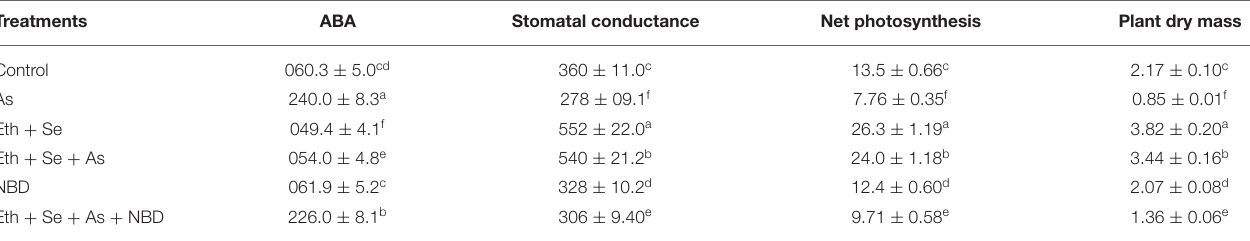
TABLE 4 | The ABA content (pmol g − 1 FW), stomatal conductance (mmol CO 2 m − 2 s − 1 ), net photosynthesis ( µ mol CO 2 m − 2 s − 1 ), and plant dry mass (g plant − 1 ) of mustard plant ( B. juncea L.) grown with 200 µ l L − 1 Eth and/or 2-mg Se kg − 1 soil in the presence or absence of 24-mg As kg − 1 soil at 30 DAS. Treatments